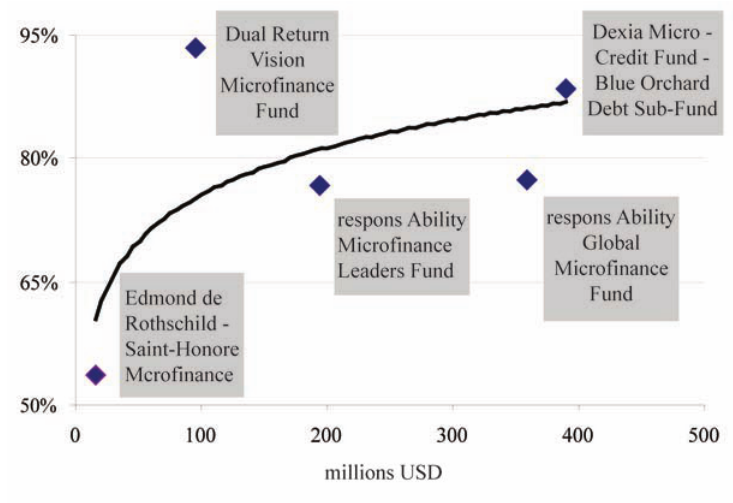
Fig. 1. Fund Assets and Their Share Allocated in Microfinance Source: http://www.mixmarket.org, MIVs‘ monthly or annual reports, own